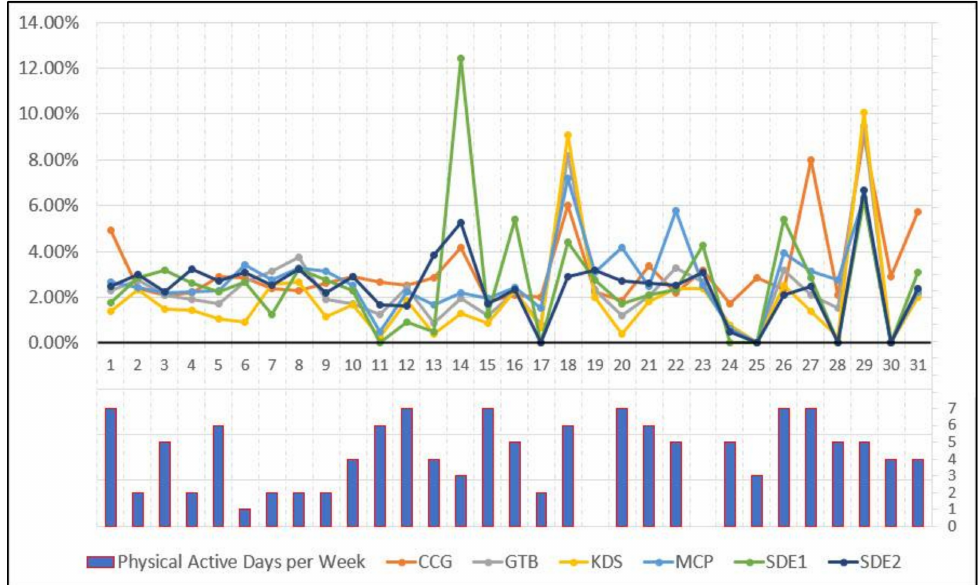
Figure 11. The physical-activity-friendly contextual exposures assessed by the different activity space methods and the physical active days per week for the 31